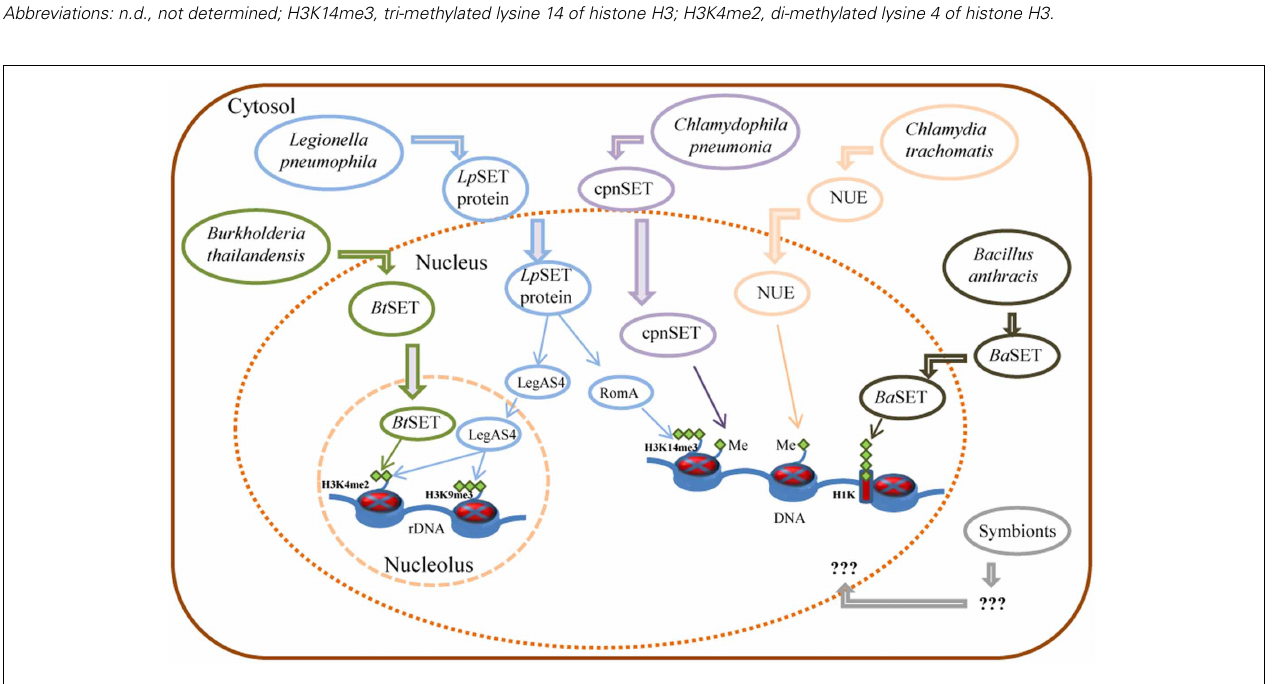
cells, as detailed in the text. Me: histone methylation; H3K14me3: tri-methylated lysine 14 of histone H3; H3K4me2: di-methylated lysine 4 of histone H3; H3K9me3: tri-methylated lysine 9 of histone H3; H1K: histone H1